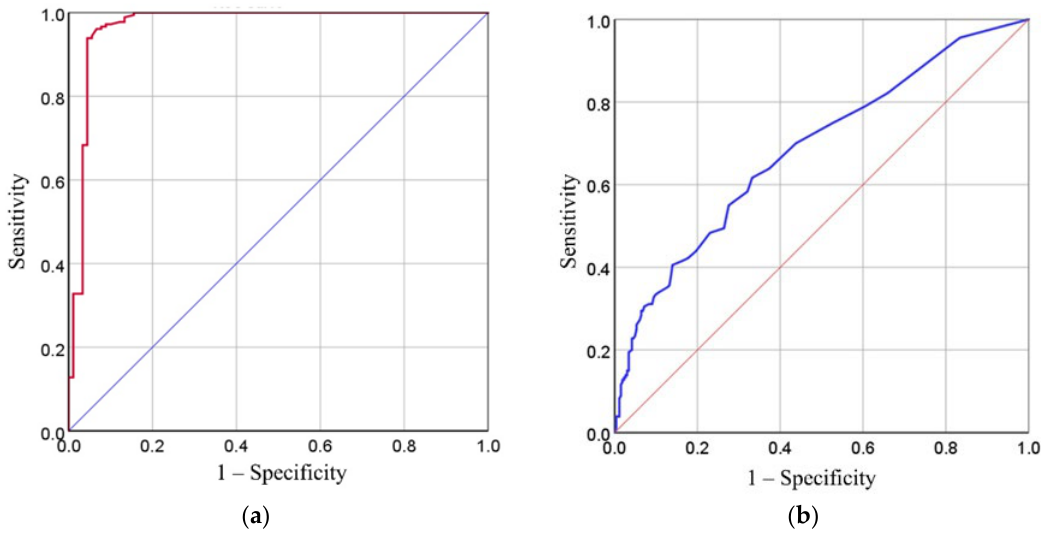
Figure 2. ( a ) ROC curve analysis for rKRP42 serum ELISA; ( b ) ROC curve analysis for anti-rKRP42 urine ELISA.